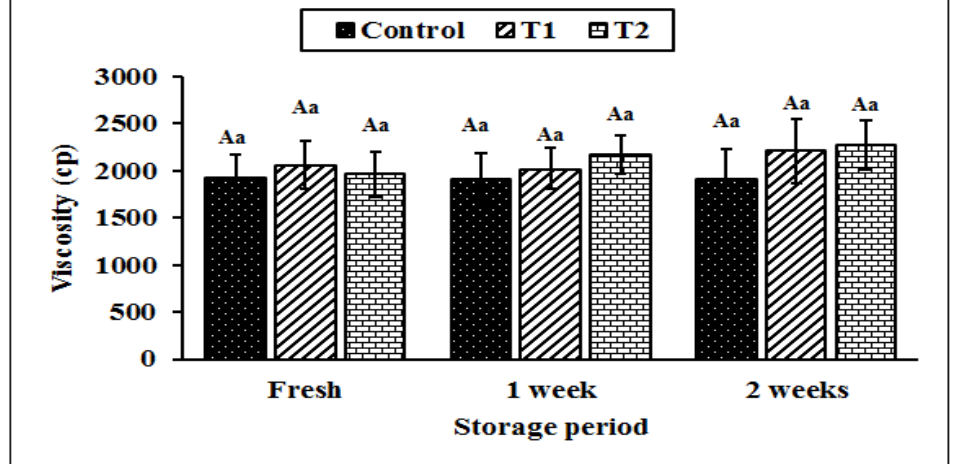
Figure 7. The effect of different concentrations of chromium (CrPic) on the viscosity of yoghurt during storage. Control without Cr (CrPi), T1 with 0.25 ppm Cr (CrPi), T2 fortified with 0.5 ppm Cr (CrPi). Data are mean ± SE for three replicates. Means with different small letters are significantly different between the treatments ( p ≤ 0.05). Means with different capital letters significantly differ between the storage periods ( p ≤